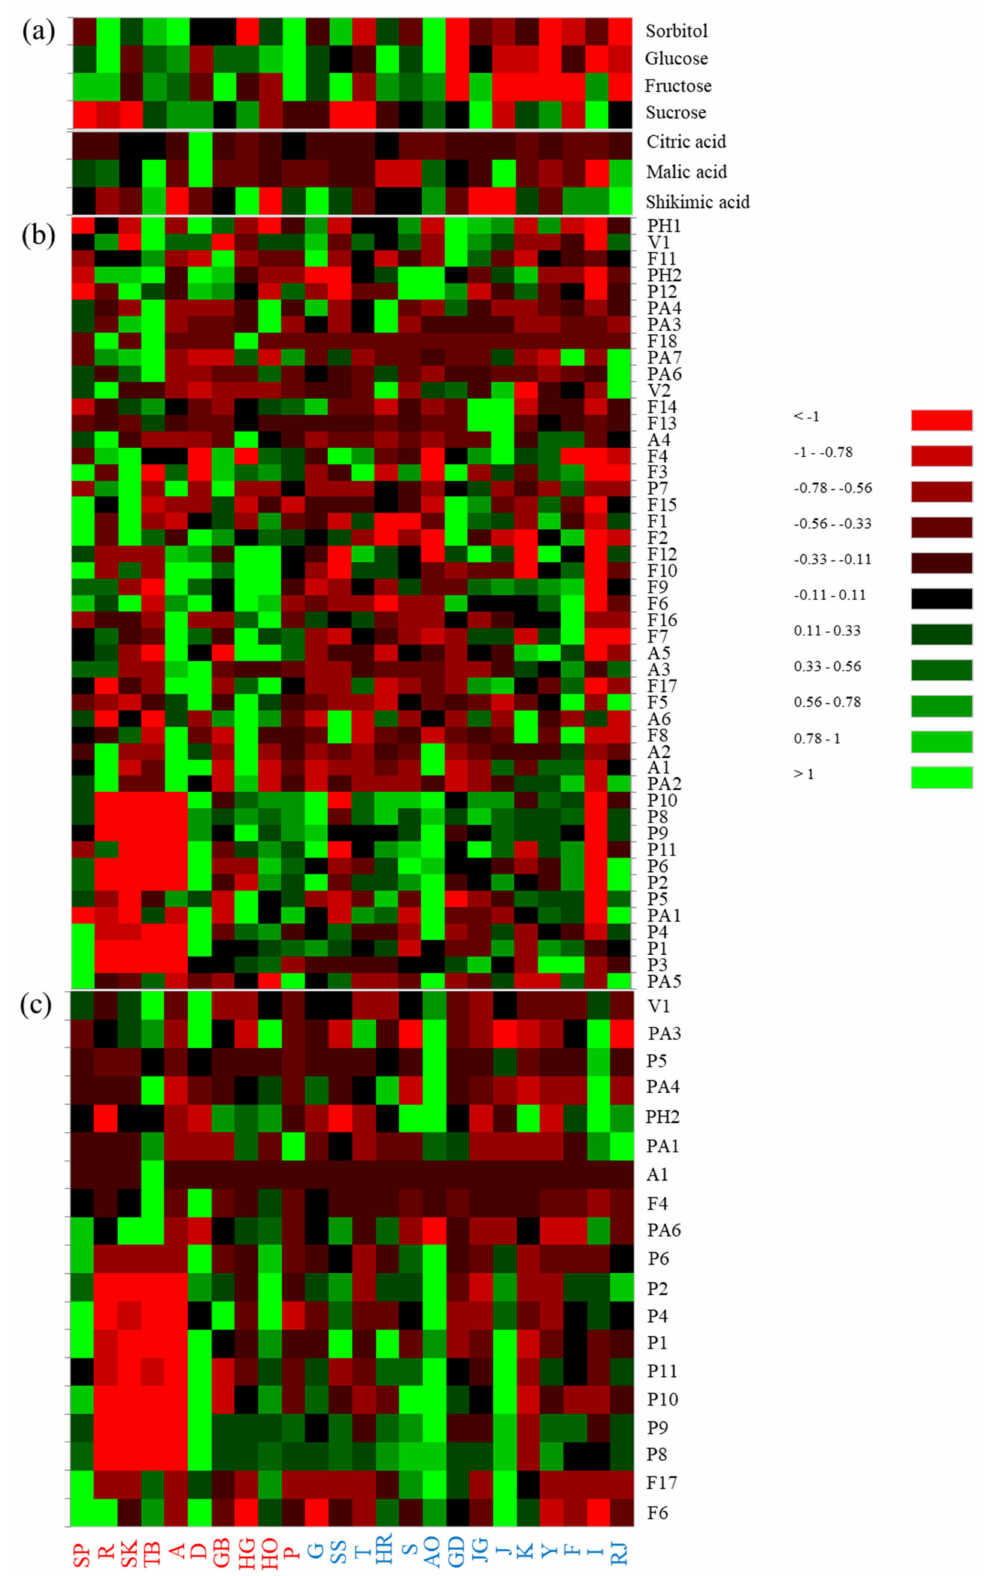
Figure 5. Heatmap visualization of di ff erences in the identified apple metabolites (free sugars and organic acids ( a ), phenolics in the peel ( b ), and in the pulp ( c )) in di ff erent apple cultivars (red and blue color in bottom of heatmap = new apple cultivars and traditional apple cultivars, respectively). Green and red colors presented in the heatmap indicate values above and below the mean centered and scaled expression values, respectively. Black indicates values close to the